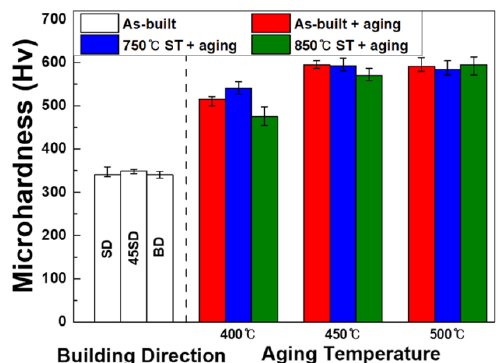
Figure 3. Effect of building direction and heat treatment condition on hardness of maraging steel fabricated by selective laser melting (SLM). Note that the hardness of the aged test pieces was evaluated on the scanning direction (SD).